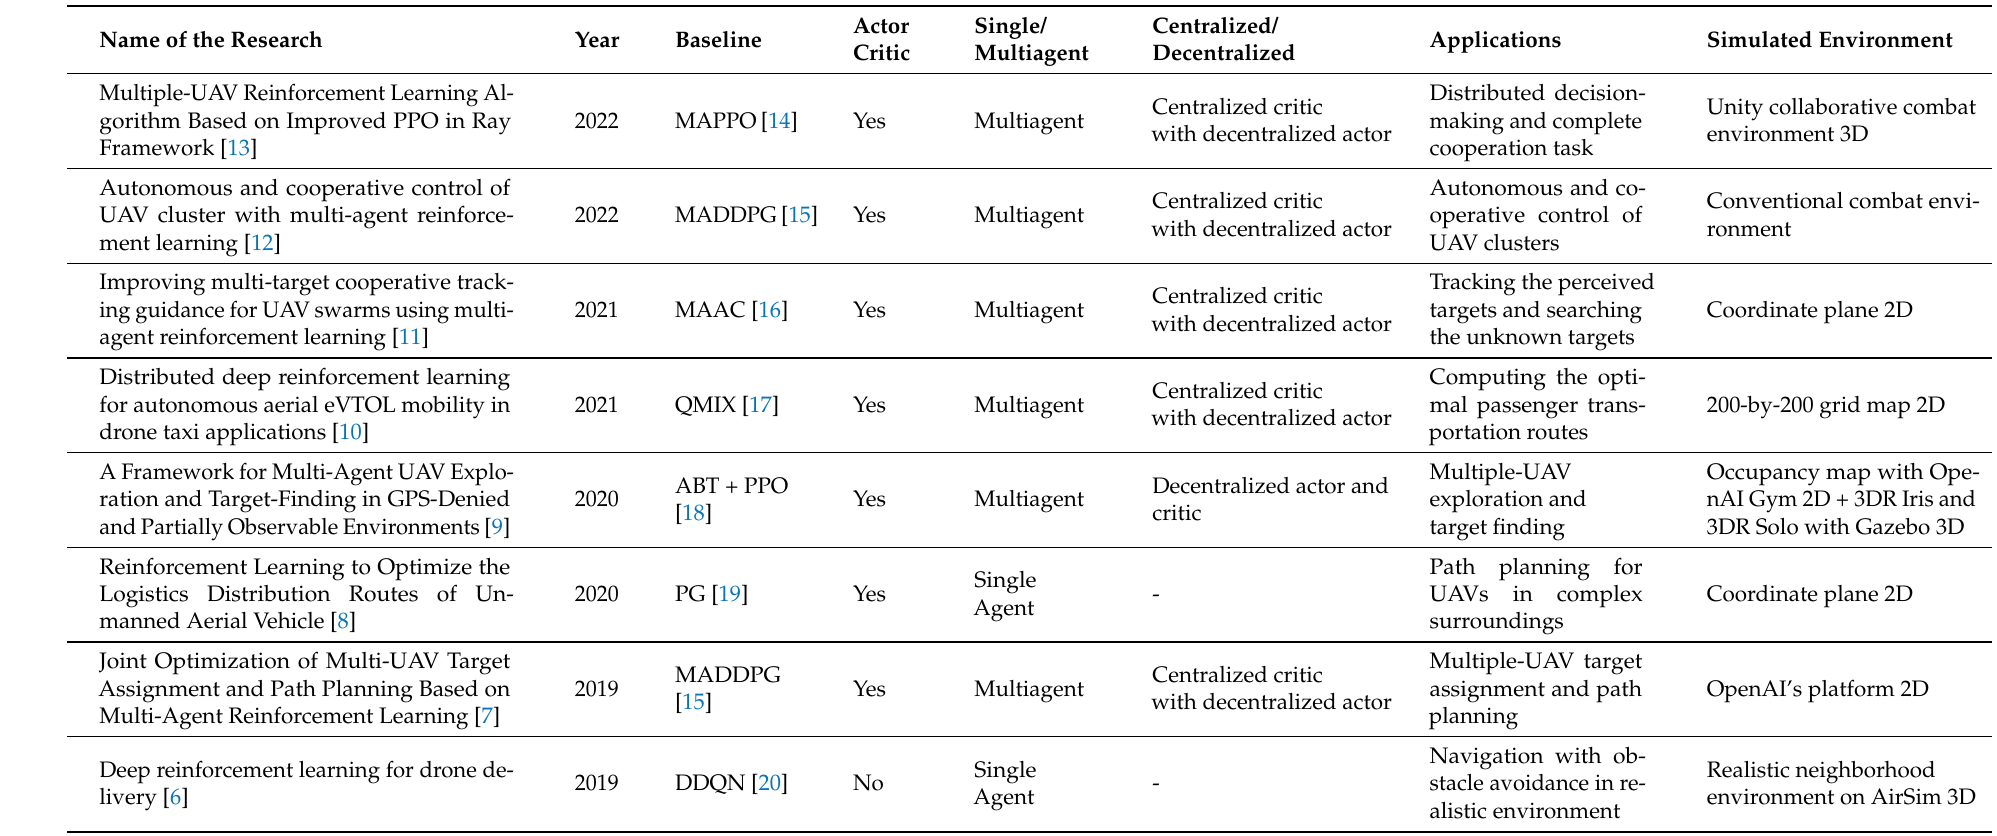
Table 1. Comparison of RL-based UAV